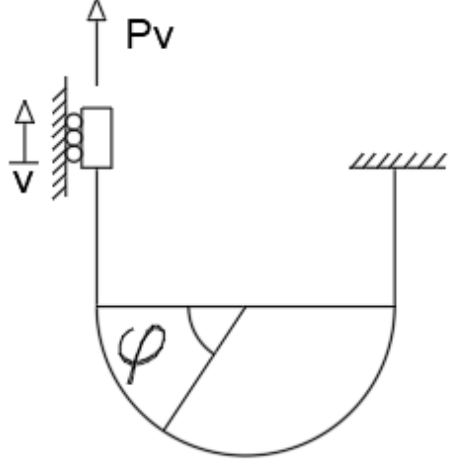
Figure 1. Vertical direction.